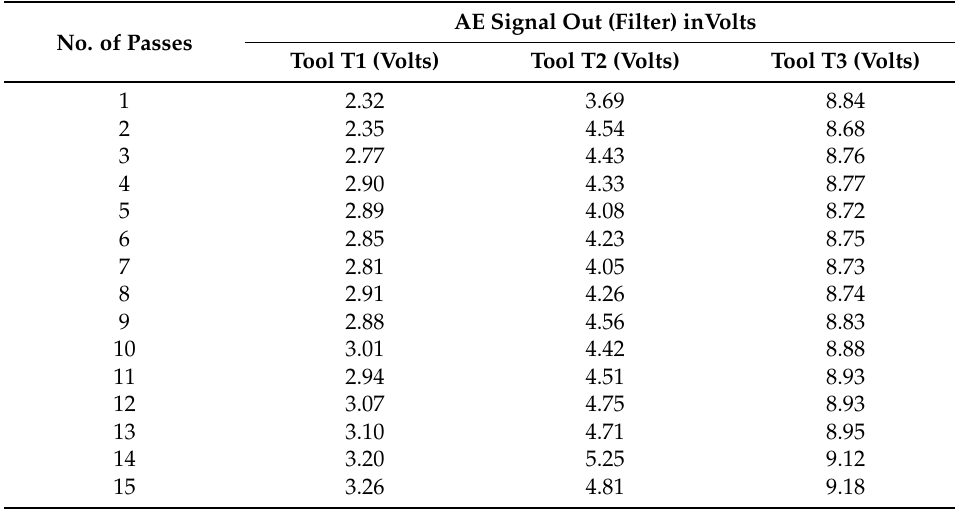
Table 5. AE signal Out (Filter) inVolts for different passes.